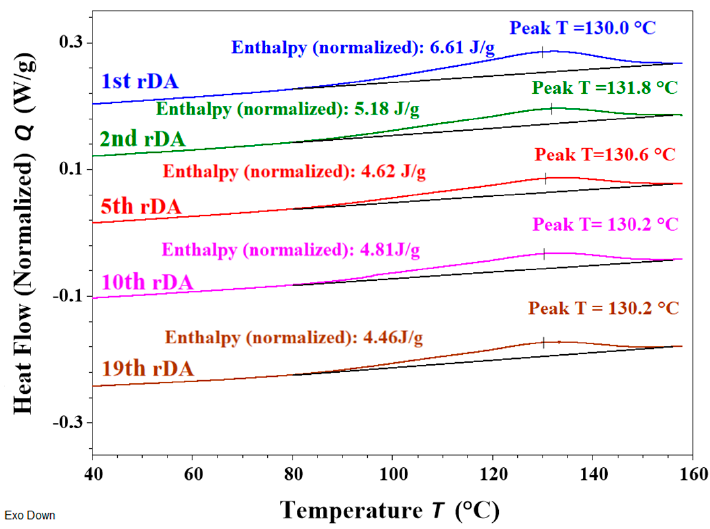
Figure 5. DSC consecutive heating scans at 10 °C/min for the sample PUR-B06 (33%TB).